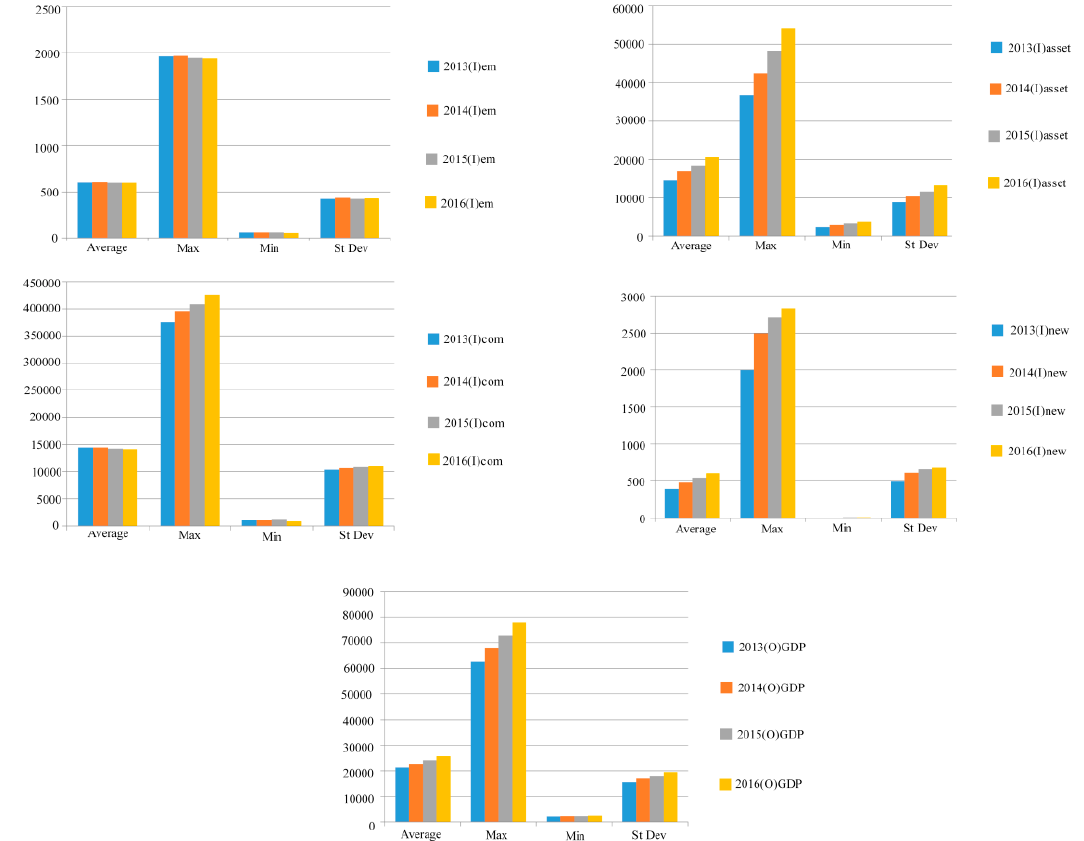
Figure 1. Input and output indicators. Sources: the Chinese Statistical Yearbooks [52], the Demographics and Employment Statistical Yearbook of China, and the City Statistical Yearbooks [53].